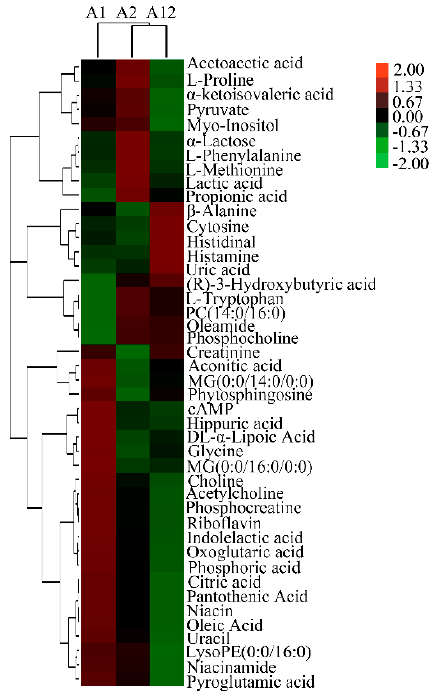
Figure 1. Hierarchical clustering of differential metabolites from β -casein variants A1/A1 (A1), A2/A2 (A2), and heterozygote A1/A2 (A12) milk. PC(14:0/16:0): Phosphatidylcholines (14:0/16:0); MG(0:0/16:0/0:0): Monoradyglycerols (0:0/16:0/0:0); cAMP: cyclic adenosine monophosphate. 3.3. Metabolic Pathways of Differential Metabolites Among β -Casein Variants.